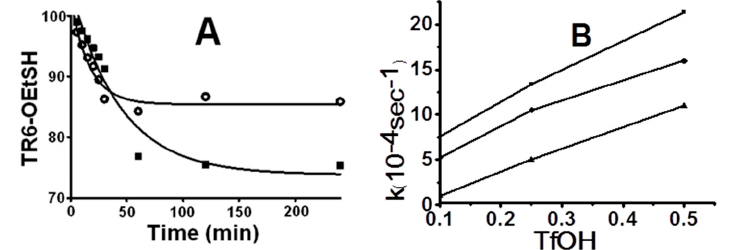
Figure 1. Time courses and rate effect on the basis of disappearance of TR6-HET and TR6-HPT at different conditions: ( A ) the time courses of peptide TIGGIR-HET disappearance in 5% TC-TFA ( ■ ) and TFA only ( ● ); and ( B ) rate effect of the TfOH additions on disappearances of TIGGIR-HET in 5% TC-TFA ( ● ), TIGGIR-HET in 5% TC-TFA ( ■ ), and TIGGIR-HPT in 5% TC-TFA ( ▲ ). To examine the effect of further increase in acidity, the first-order rates of TR6-HET in TFA and 5% TC-TFA conditions were compared with 0.1%, 0.25%, and 0.5% TfOH ( v/v ) additions. The experiment gave rise to distinct rates of 1,2-elimination and O-S acyl shift, while the main products detected were peptide-TCs in TC-TfOH-TFA (Scheme 2A,B), peptide-TFA adducts in TfOH-TFA (Figure S2), and peptide-OHs in TFA only (Figure S1). The 1,2-elimination progressed relatively slowly, compared to